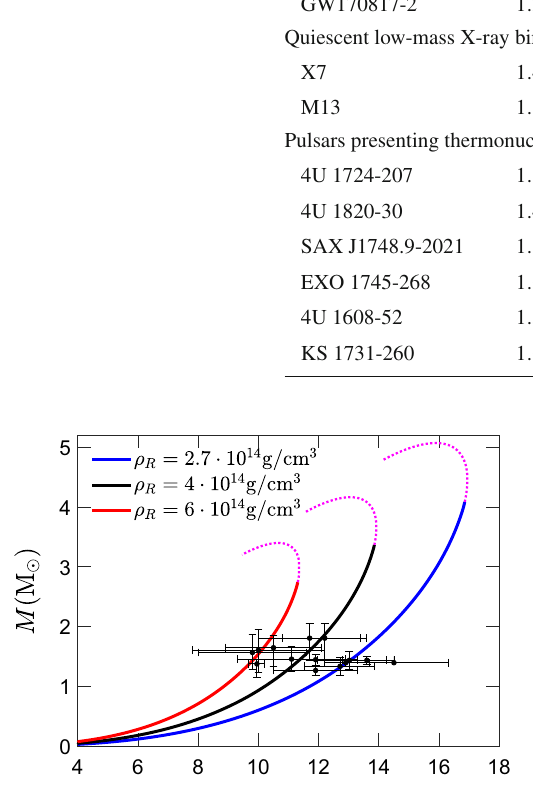
Table 1 The boundary density ρ (ρ) linear R and slope of the p r fit within our model for several observational data of mass M and radius R of pulsars. The “LIGO constraints” label refers to the radius constraints on a canonical mass neutron star obtained from GW170817,